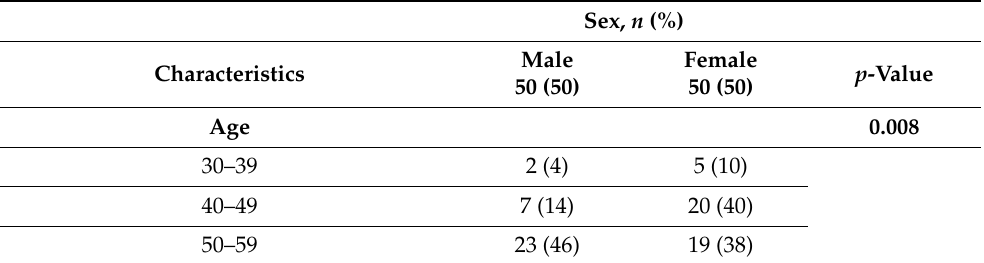
Table 1. Characteristics of patients ( N =